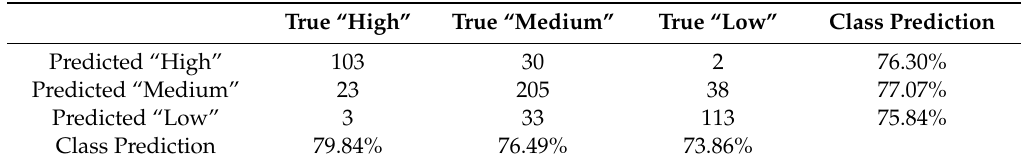
Table 5. Confusion matrix of the random forest (RF) model.